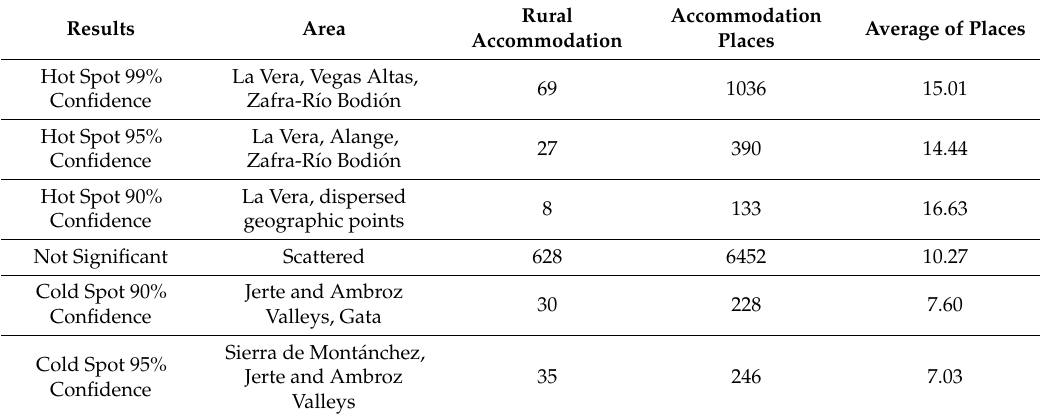
Table 3. Results of the hot spot